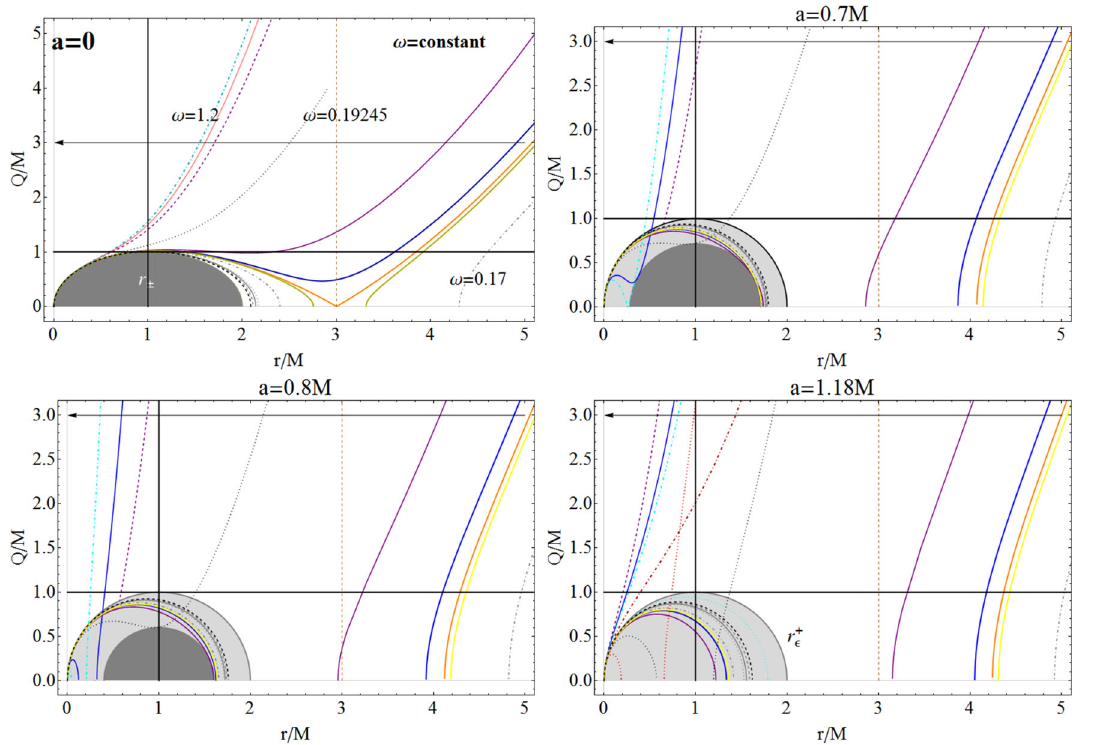
the analysis shown in Fig. 8 to the case Q (cid:20)= 0. The black region is for r < r ± and the gray region is the ergosurface (cid:21) + (cid:9) . See also Fig.